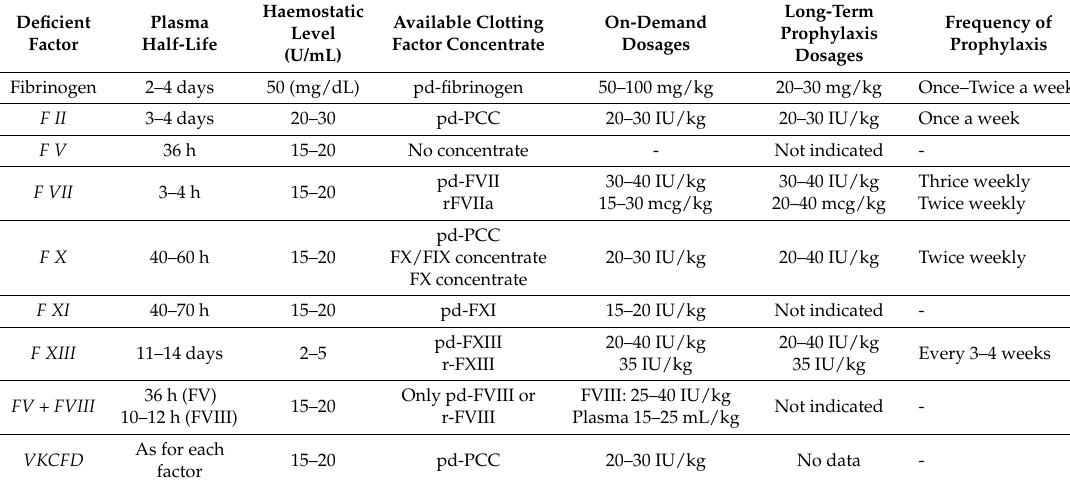
Table 6. Replacement therapy for